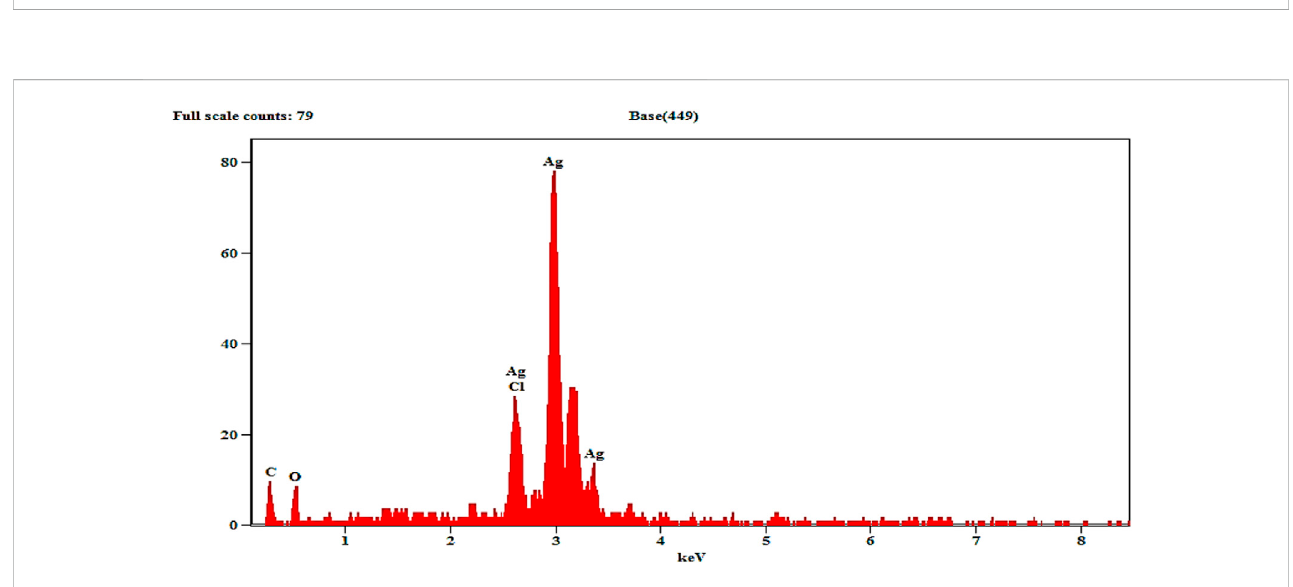
FIGURE 5 Energy dispersive X-ray spectrum of as-prepared SOR-AgNPs.